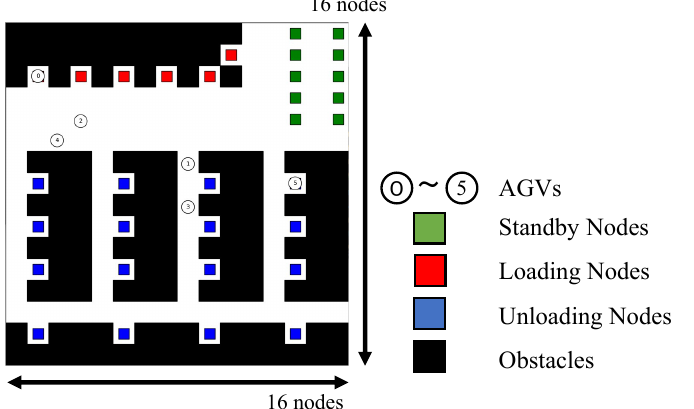
Figure 3. A model of warehousing system with obstacles. Each AGV is initially located at its standby node. Tasks are then assigned to each AGV, which moves to the indicated loading and unloading nodes in that order.